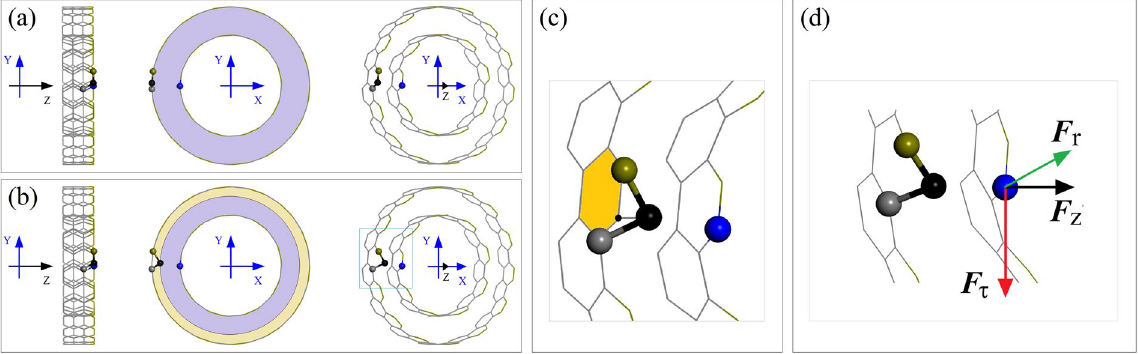
Figure 2. Schematic of IRD of an atom on the outer tube in double-wall CNTs (DWCNTs) with one unit along the axis. ( a ) Side, axial, and oblique views of DWCNTs without IRD of any atom. ( b ) The IRD is positive with the value equal to the width of the yellow zone. The black IRD atom moves closer to the inner tube, e.g., a blue atom on the inner tube. ( c ) Amplified local relative positions of atoms with or without IRD. ( d ) The components of repulsion on a blue atom subjected to the outer tube. F τ and F r are the tangential and radial components within the cross-section, and F z is the component along the Z-/tube